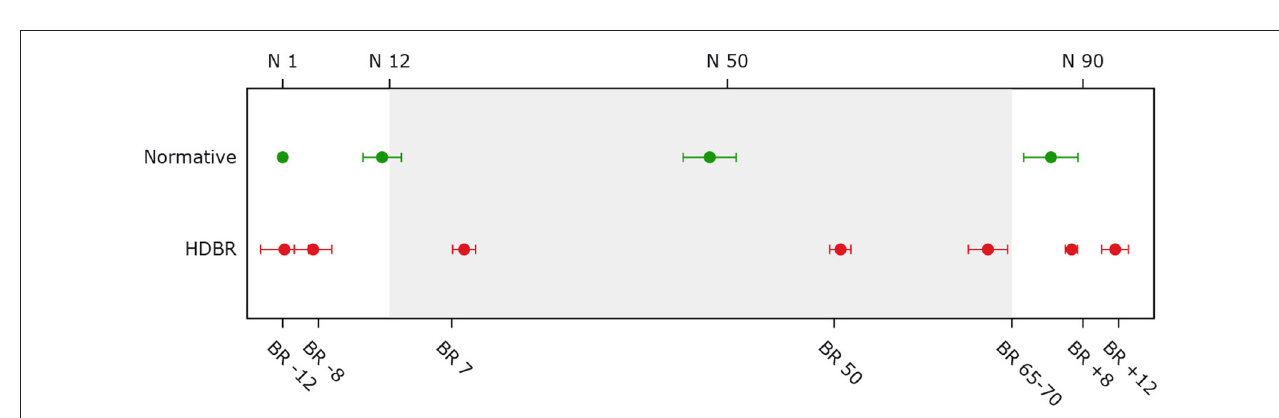
FIGURE 1 | Testing timeline for head down tilt bed rest (HDBR) and normative subjects. The top x-axis shows time in days for the bed rest subjects (e.g., BR -8 = 8 days pre-HDBR). The bottom x-axis shows time in days for normative subjects. The gray background indicates the bed rest period. BR Cognition = Time points at which cognitive assessments (i.e., digit symbol substitution test, Purdue pegboard test, rod and frame test,